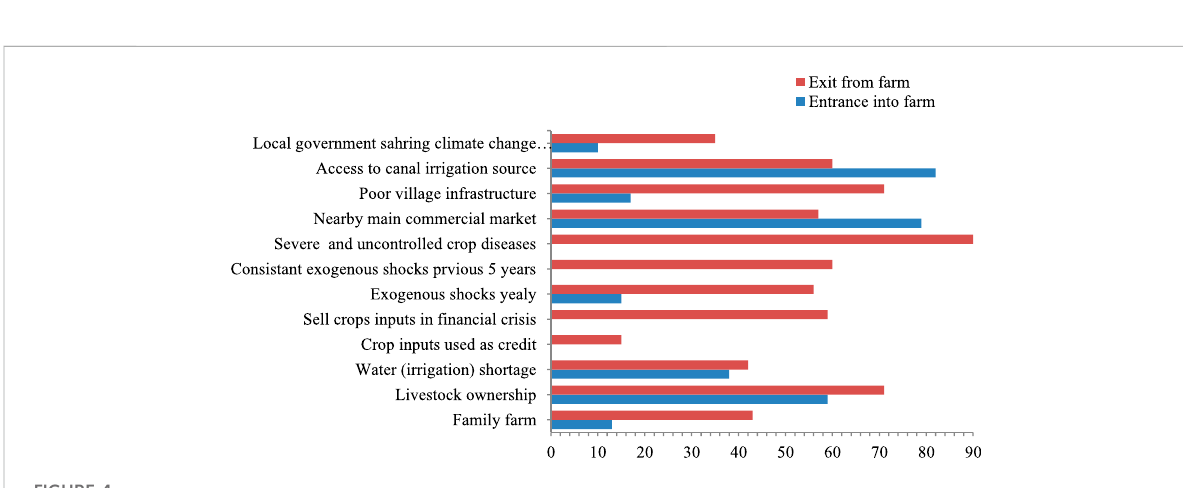
FIGURE 4 Perceived main factors for entrance and exit into and from farming (percentage of households who responded